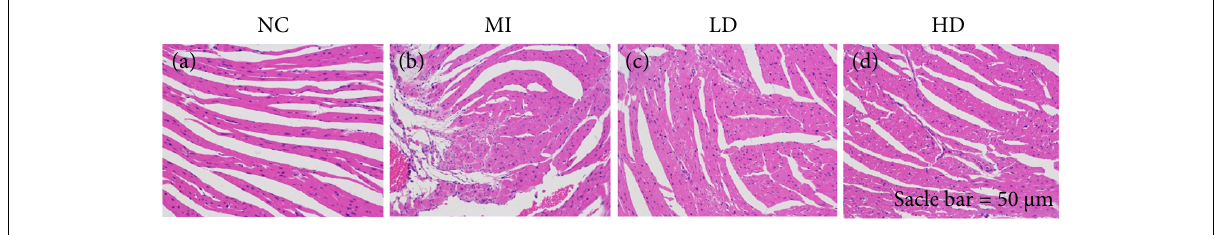
Figure 2 - Histopathological examination of effect of jatrorrhizine in mice with MI. a-d: H&E staining. Intact structure of myocardium (a) was lost due to MI, instead of massive fibrosis and infiltration of inflammatory cells (b) ; administration of LD jatrorrhizine (c) and HD jatrorrhizine (d) effectively recovered